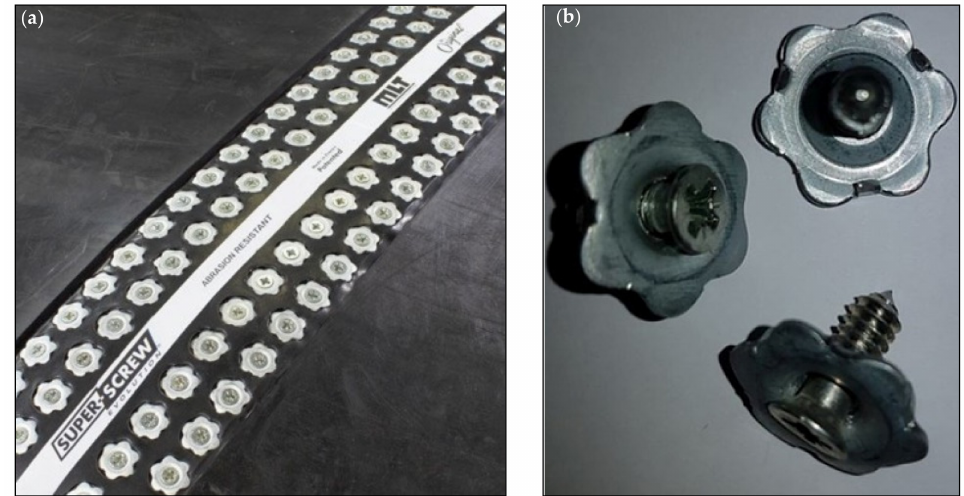
Figure 25. Screws rubber splice fastening: ( a ) general view; ( b ) view of the screw embedded in a insert with hooks